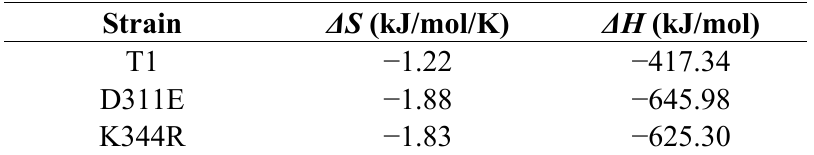
Table 2. Thermodynamic parameters for the thermal denaturation transition of T1 lipase and its mutants as calculated from CD